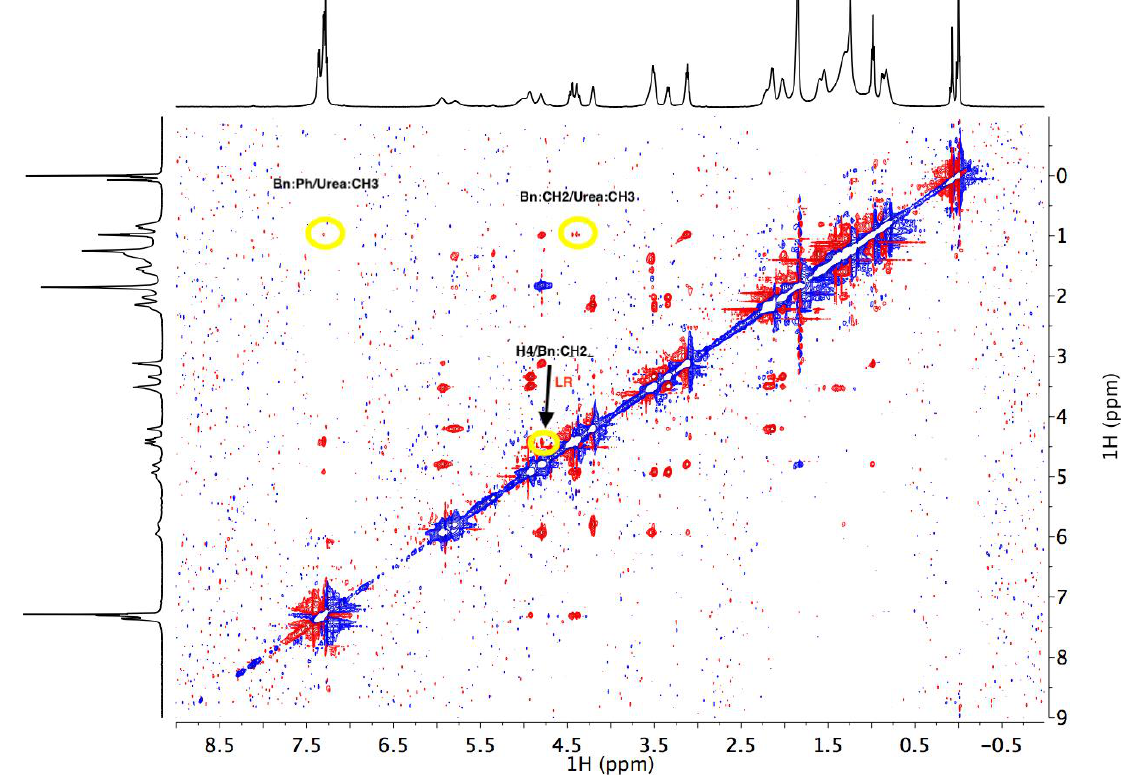
Figure 12. 2D NOESY spectrum of compound 3 at − 10 °C, t-mix = 600 ms (CDCl 3 , 500 MHz). Sign of NOE peaks; red negative, blue positive.